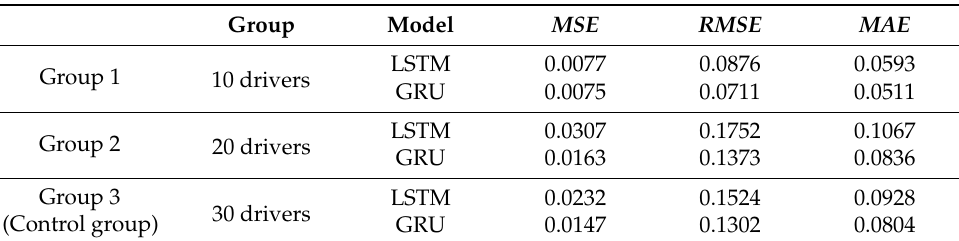
Table 5. Prediction performance of LSTM and GRU for different driver subgroups.